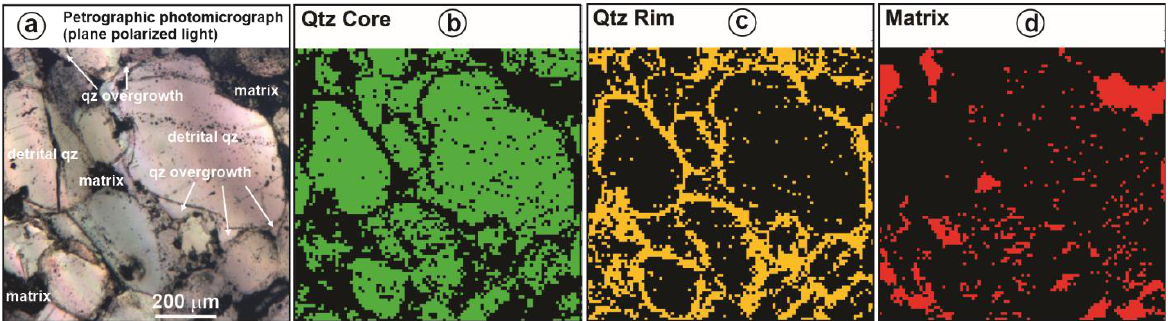
Figure 2. Photomicrograph of sample #1425 ( a ) and digitized distribution of detrital quartz ( b ), quartz rim ( c ) and matrix ( d ). Criteria used for the digitization are explained in the text.